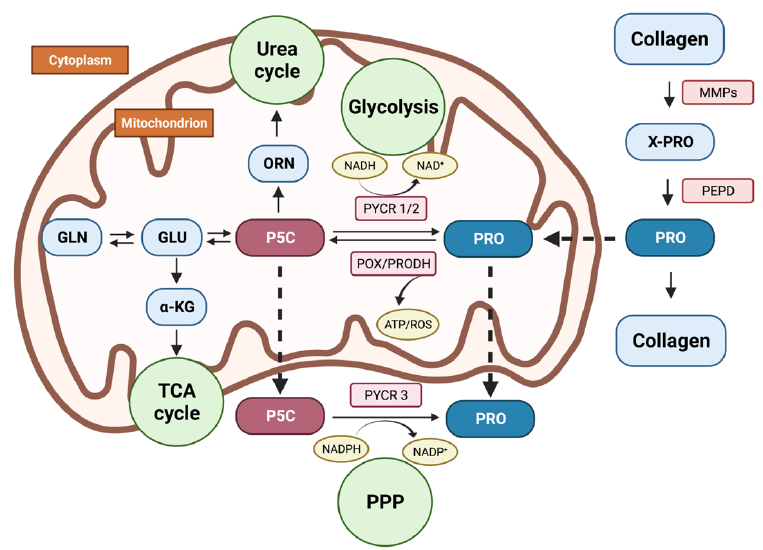
Figure 1. Proline cycle and its basic metabolic links in the human cell. Proline released during collagen catabolism can feed back to collagen resynthesis, or, through the proline cycle, it may be used for energetic purposes, redox balance, parametabolic regulation, or anaplerosis. PRO— proline, P5C—pyrroline-5-carboxylate, ORN—ornithine, GLN—glutamine, GLU—glutamate, α KG— alpha-ketoglutarate, PEPD—prolidase, POX/PRODH—proline oxidase/proline dehydrogenase, PYCR 1/2/3—pyrroline-5-carboxylate reductase 1/2/3, MMPs—metalloproteinases, PPP—pentose phosphate pathway, TCA cycle—tricarboxylic acid cycle. Created with BioRender.com, accessed on 2 February